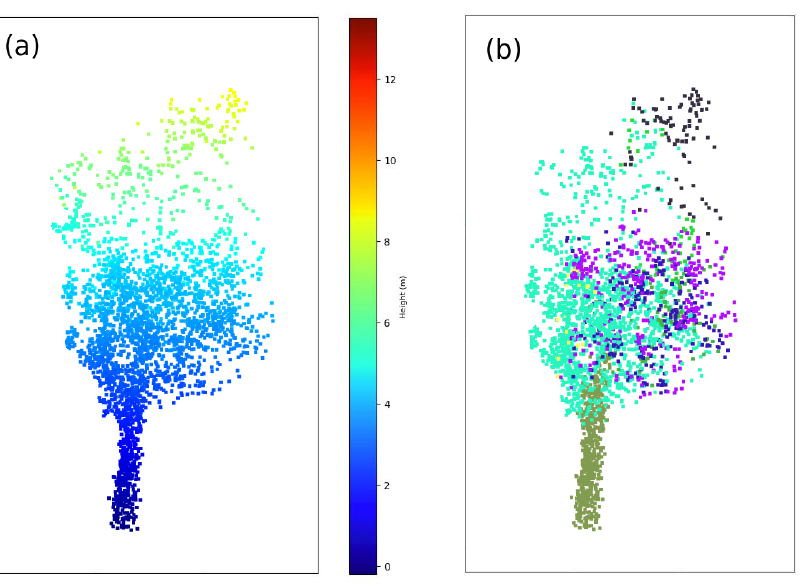
Figure 9. ( a ) Cylinder cloud subtracted. ( b ) Subclustering of the cylinder point cloud. Once all subclusters are classified, merging the floating segments consists of assigning them to the closest ground-connected segment. In Figure 10, there is an example of the point cloud’s state before and after this process. In the left panel, there are some groups of points that do not seem to match their correspondent tree, i.e., the floating segments, so after identifying them by evaluating their vertical continuity, they are merged with the closest ground-connected segment. After repeating this process with all cylinder point clouds, there will be a remaining group of points without any classification yet. We will call them discarded points , and their analysis will be the last step of the algorithm’s procedure.